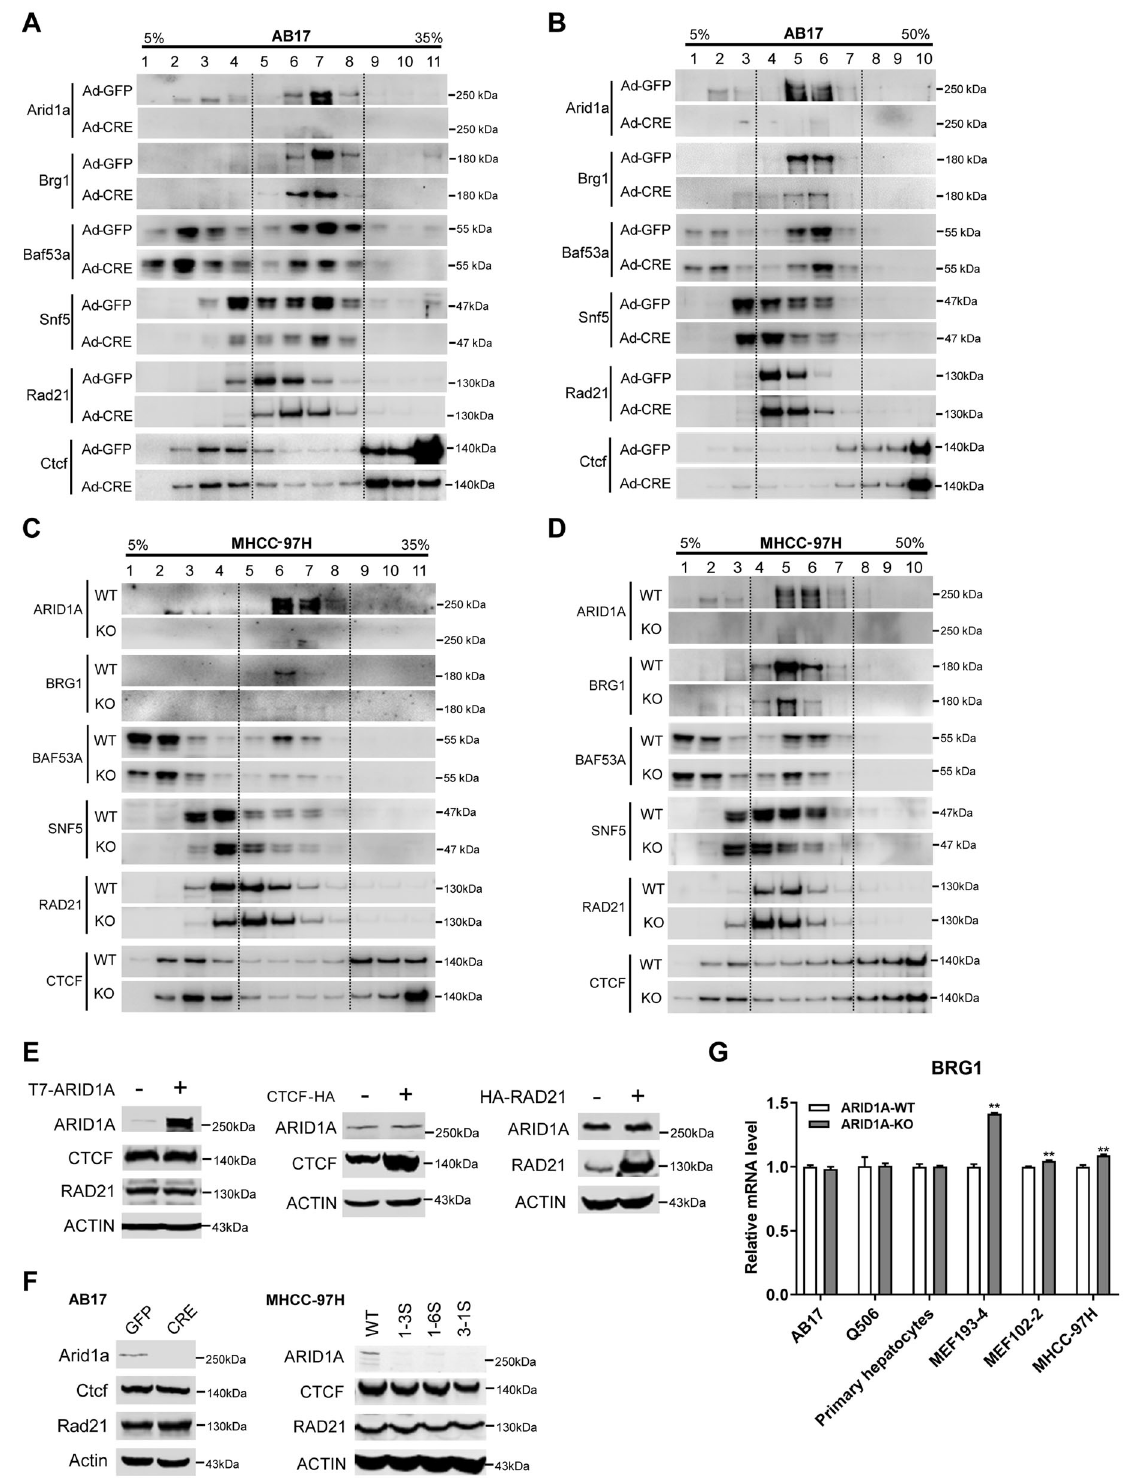
Fig. 3 ARID1A de fi ciency weakens BRG1-RAD21 axis via BRG1 suppression. A Glycerol sedimentation assay with 5 to 35% gradients for detecting the co-segregation of Brg1 and Rad21 in nuclear fractions in Arid1a WT and KO AB17 cells. The dotted lines enclose the co-density strati fi cations of Brg1 and Rad21. B Sucrose sedimentation (5 to 50%) assay in Arid1a WT and KO AB17 cells. The co-fractionation of Brg1 and Rad21 circled with dotted lines. C , D The same as A and B respectively but in HCC cell line MHCC-97H. E HEK293T cells transfected with the T7- ARID1A construct exhibited no signi fi cant impact on CTCF and RAD21 (Left). Similarly, no impact on ARID1A in CTCF (Medium) and RAD21 over-expressed cells (Right). F Neither CTCF nor RAD21 was effected by ARID1A de fi ciency in AB17 (Left) and MHCC-97H cells (Right). G Brg1 mRNA expression levels in Arid1a WT and KO AB17 cells, Q506 cells, primary hepatocytes, MEFs (193-4 and 102-2 cells), and HCC cell line MHCC-97H with three biological replicates. Error bars were painted by SEM. p value was calculated by a two-tailed Student ’ s t -test. mRNA expression of Gapdh was employed as an internal